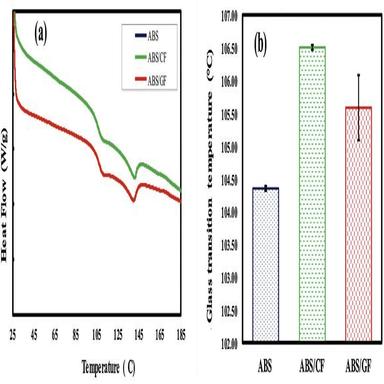
Representative single specimen DSC results of ABS and ABS based composite (a) thermogram for temperature scanning (b) comparison of glass transition temperature (average of five measurements and errors bars represent ± one standard deviation).